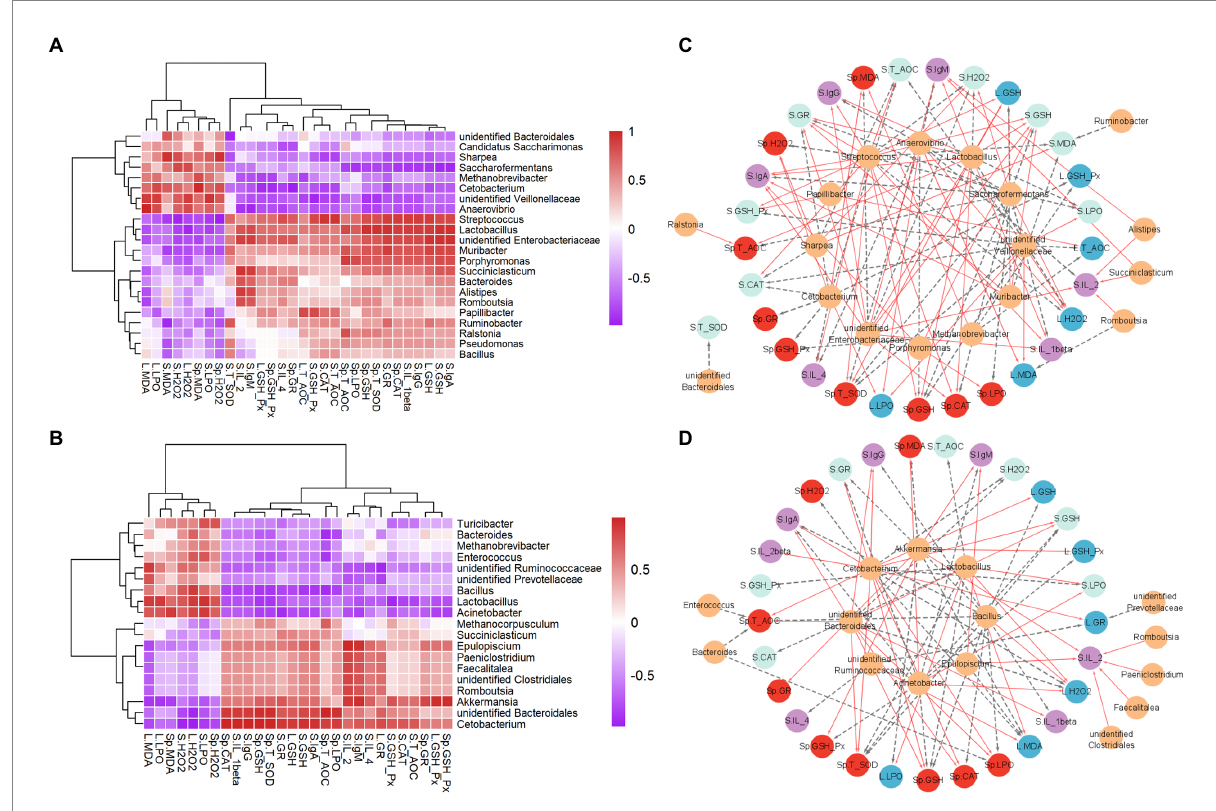
FIGURE 4 Statistical Spearman’s correlations between the rumen (A,C) or gut microbiota (B,D) and immune and oxidative stress parameters in NPG and FPG groups. (A) Heatmap of correlation between the rumen microbiota and immune and oxidative stress parameters. (B) Heatmap of correlation between the gut microbiota and immune and oxidative stress parameters. The intensity of the color represents the degree of association among them. (C,D) Visualization of the correlation network according to the correlation. Yellow nodes, the rumen microbial genera (C) , the gut microbial genera (D) ; red nodes, the spleen parameters; blue nodes, liver parameters; green nodes, the serum oxidative stress parameters; purple nodes, serum immune parameters. Red lines, Spearman’s rank correlation coefficient > 0.8, FDR adjusted p < 0.05; dotted gray lines, Spearman’s rank correlation coefficient < − 0.8, FDR adjusted p < 0.05. The line width indicates the strength of